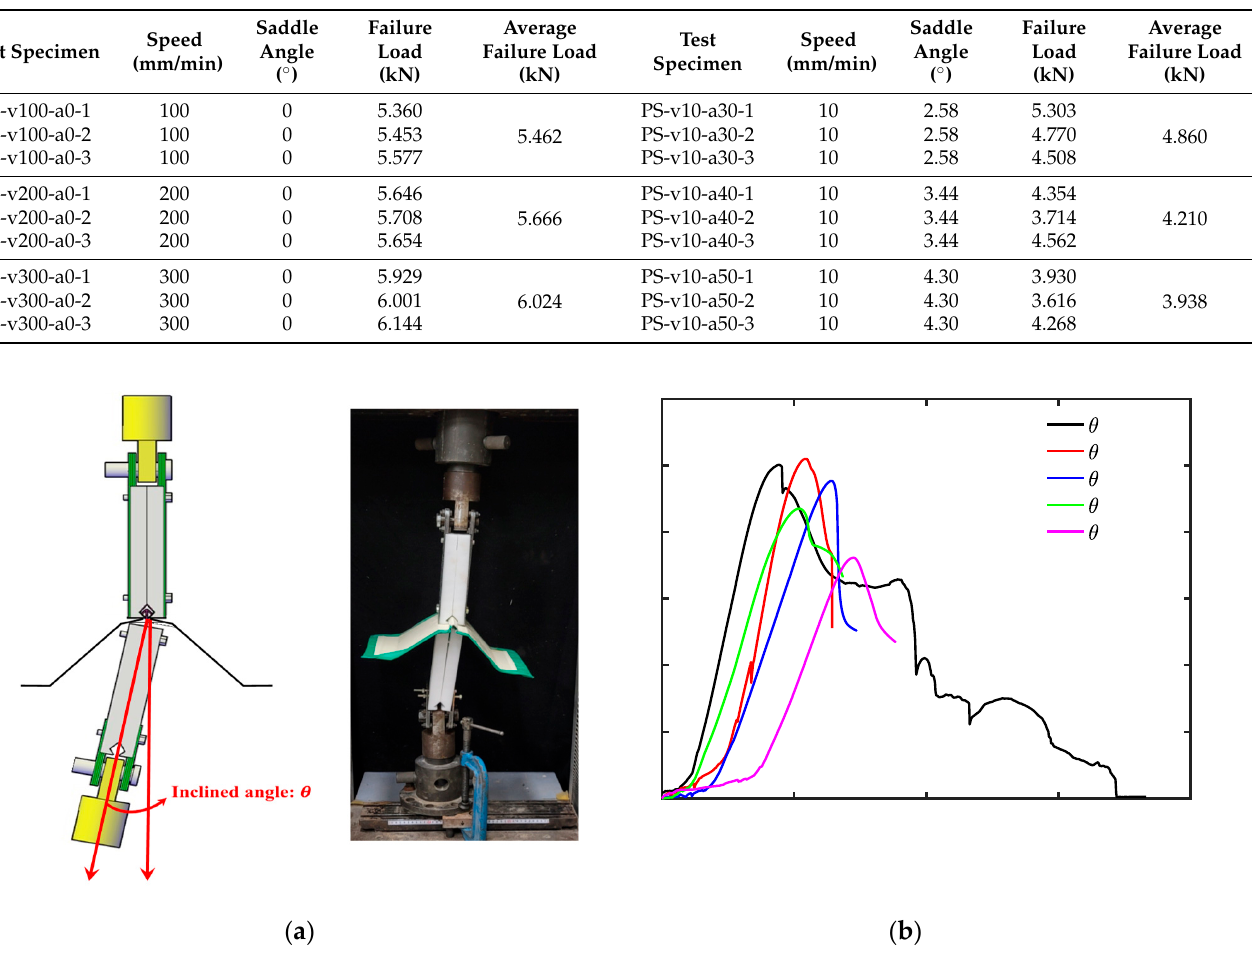
Figure 4. Experimental set-up for the inclined plastic saddle tests. ( a ) Schematic design, ( b ) load vs. displacement curves at various saddle angles. Table 2. Test results of lab-scale SSMR specimens.